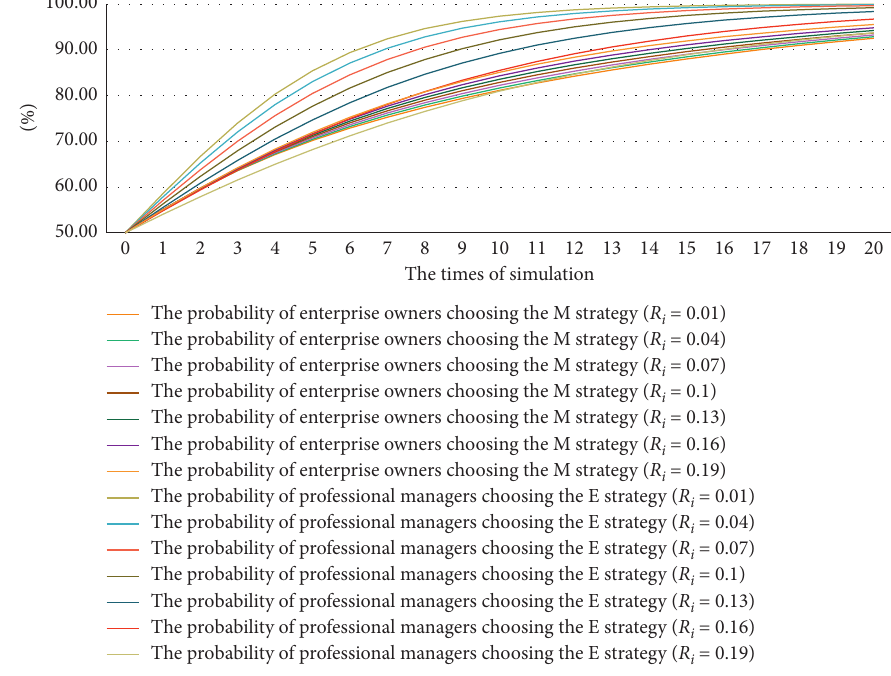
Figure 18: The impact of R i on the evolutionary results.